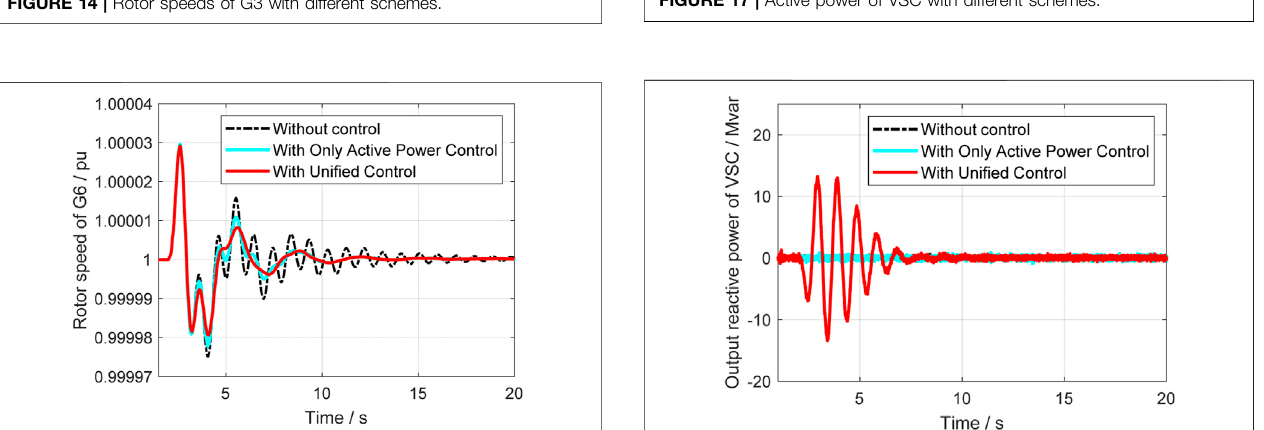
FIGURE 17 | Active power of VSC with different schemes.